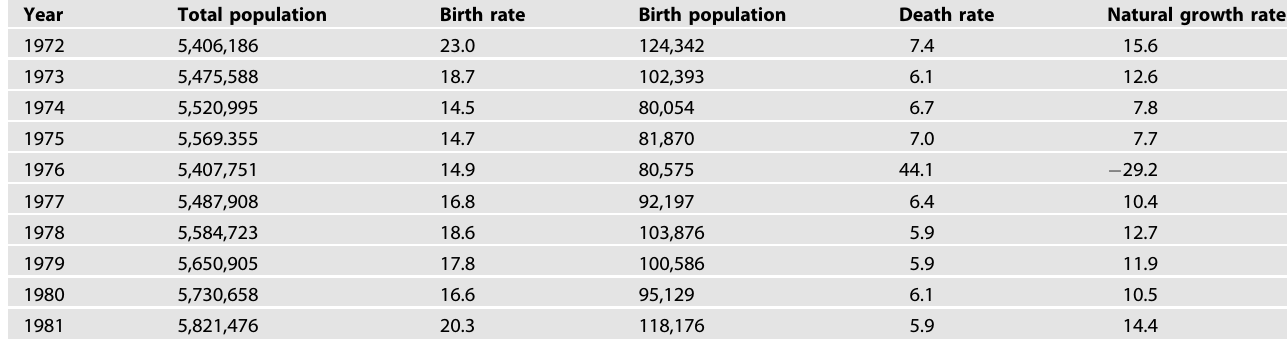
Table 1. Total population and birth, death, and natural growth rate per 1000 residents during 1972 and 1981 in Tangshan